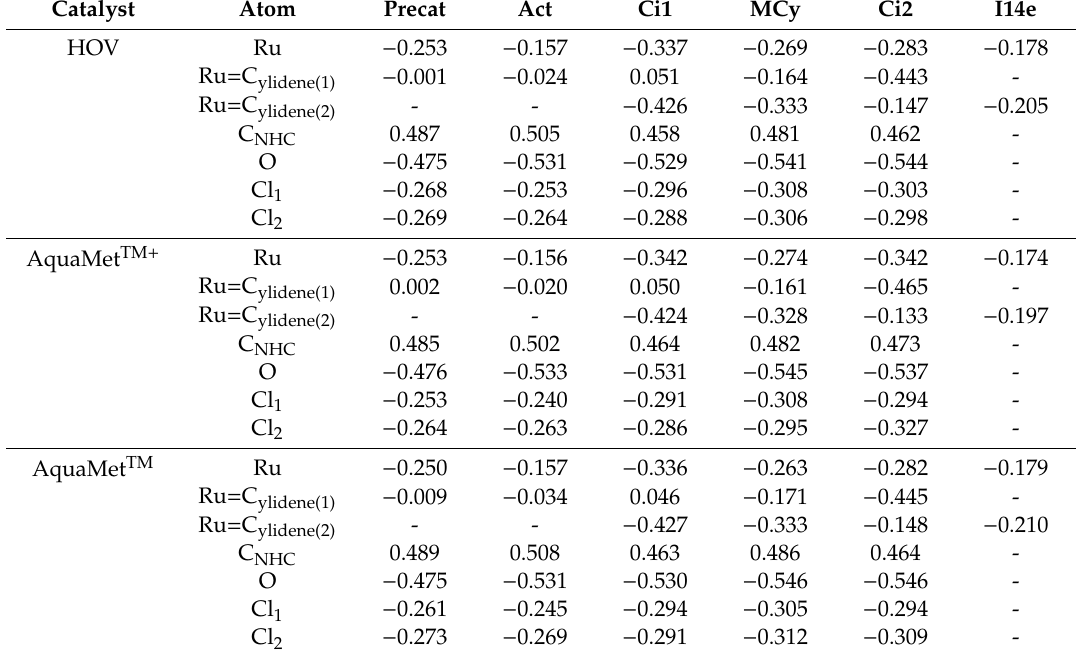
Table 4. Natural bond orbital (NBO) charge analysis on the metal, oxygen, two C ylidene , C NHC and two chlorides (in e −